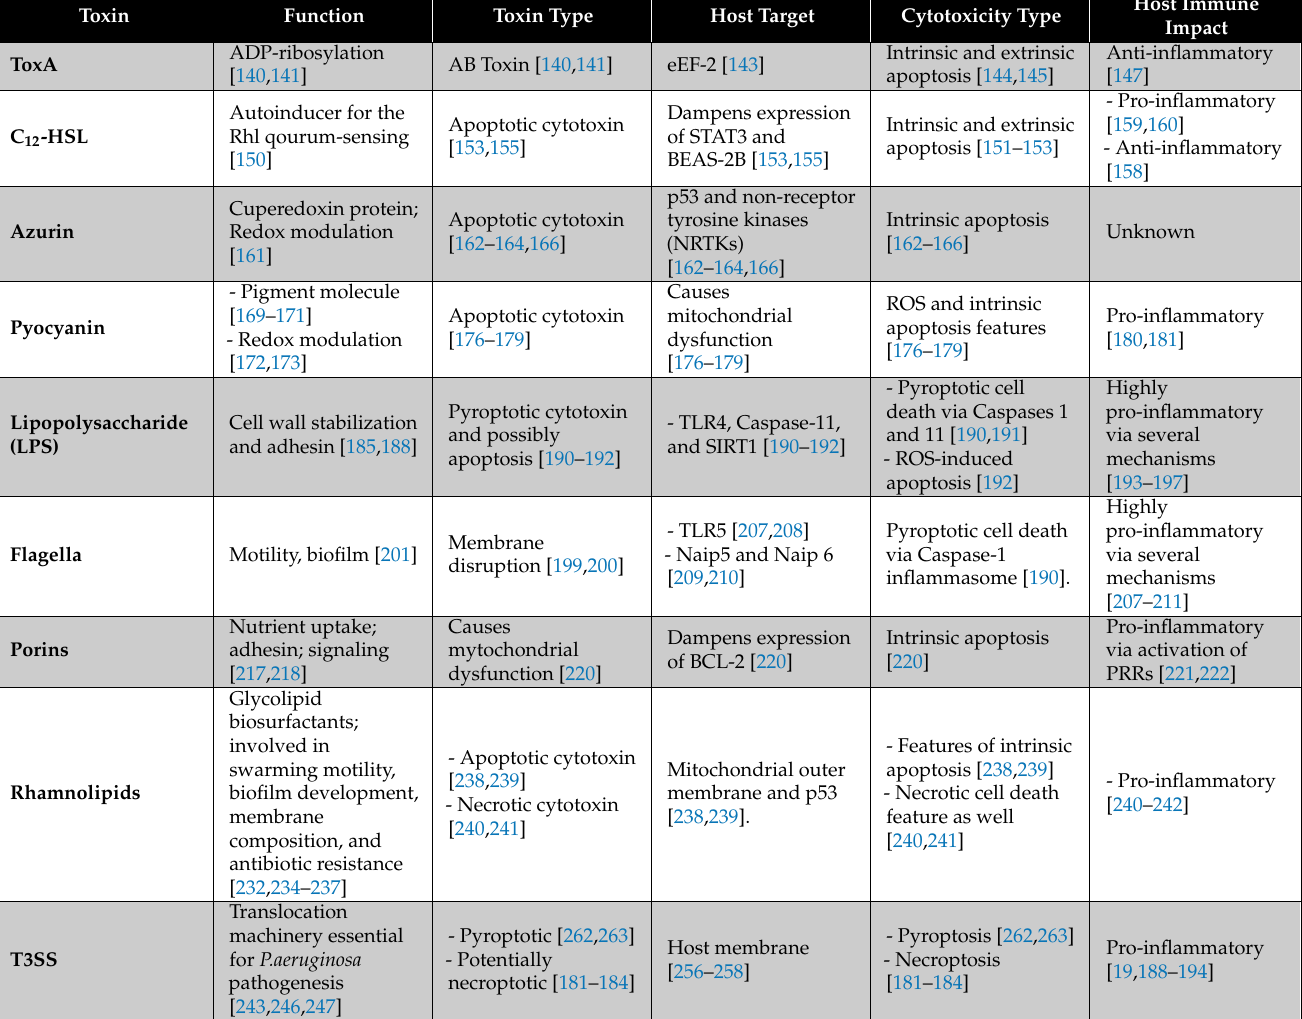
Table 1. Summary of the cytotoxic in P. aeruginosa strains and their mode of cytotoxicity and impacts on immune